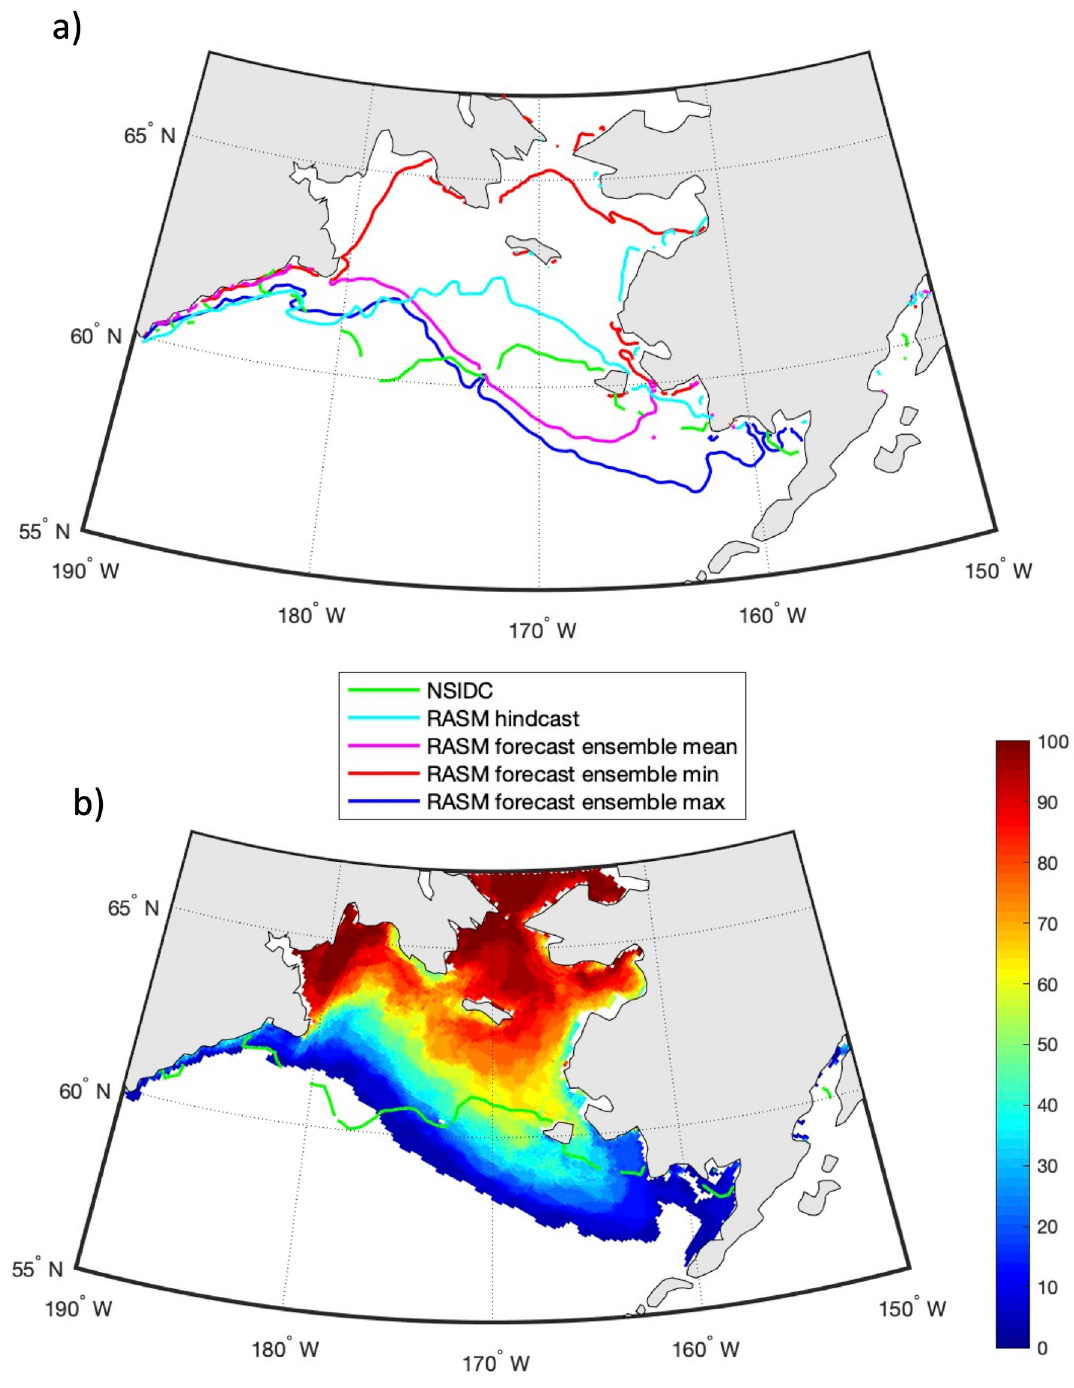
Fig 14. Predictions of sea ice extent and probability for April 15, 2021. (a) The RASM predicted ensemble mean (purple), maximum (blue) and minimum (red) sea ice extent on April 15, 2021, with all 31 individual member forecasts initialized on February 1, 2021. The green line is the NSIDC observed sea ice extent [44] on April 15, 2021. (b) The predicted probability of sea ice extent for April 15, 2021. Figure created using Matlab (v. 2018a) from the authors’ data.